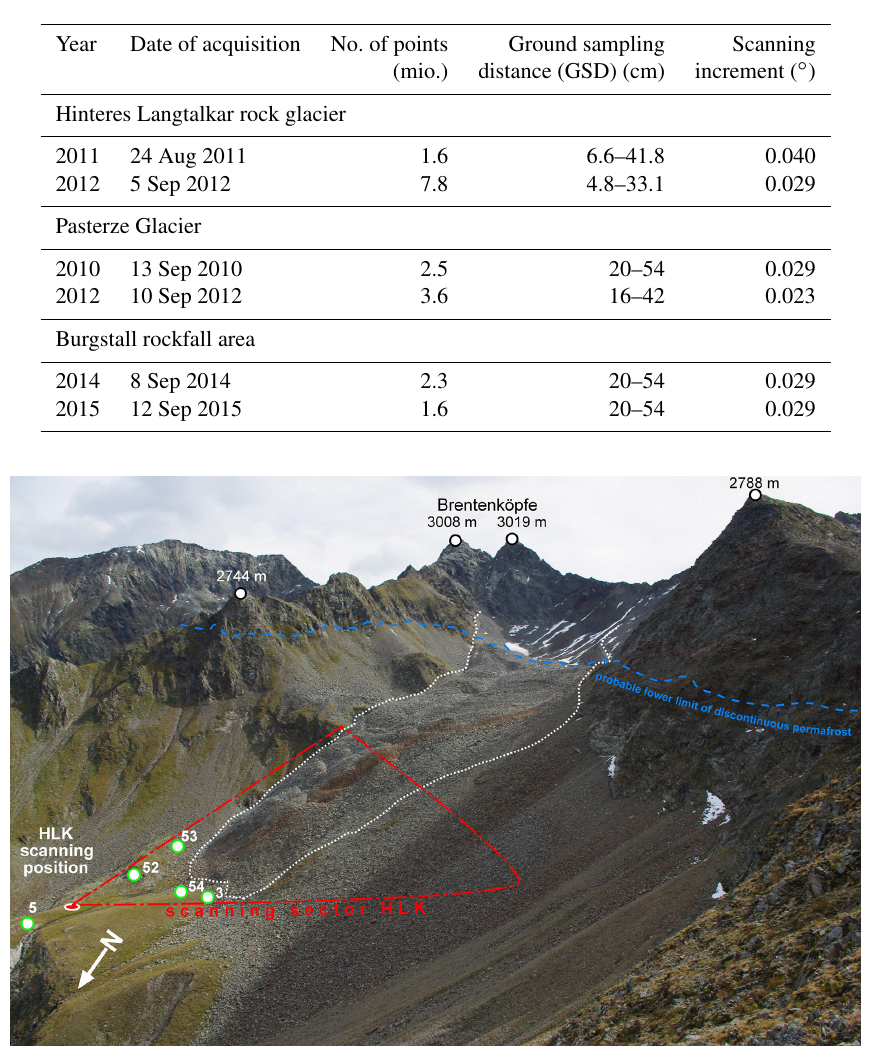
Table 1. Summary of all used measurements in every study area comprising date of acquisition, number of points (points per epoch) and ground sampling distance (GSD).